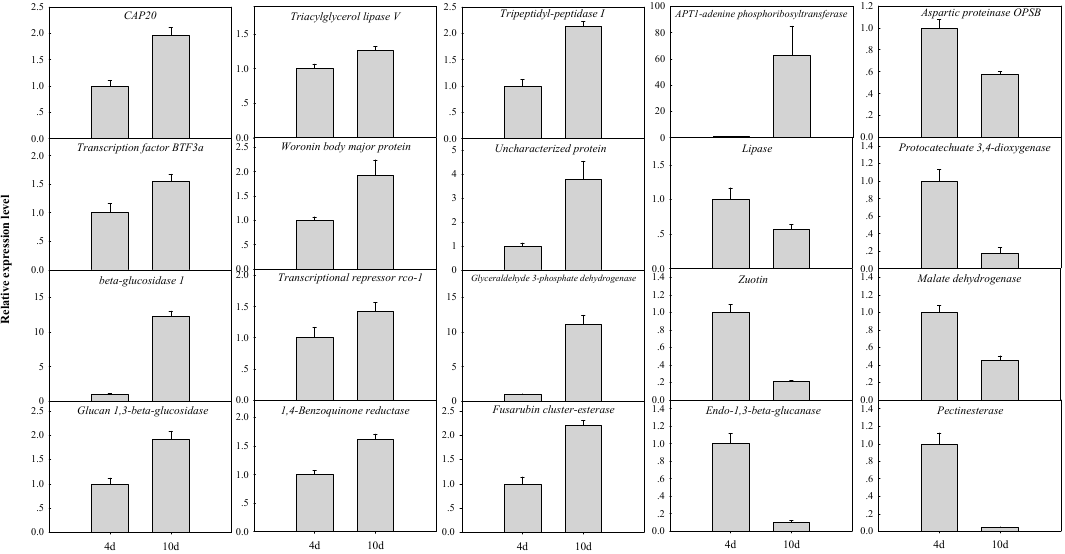
Figure 2. Fungal gene expression analysis in infected banana fruit by quantitative reverse transcriptase-polymerase chain reaction (qRT-PCR) at 4 and 10 days post-inoculation (dpi). The expression levels of each gene were expressed as a ratio relative to the day 4, which was set at 1. The descriptions of each gene were the same, as shown in Tables 1 and 2.